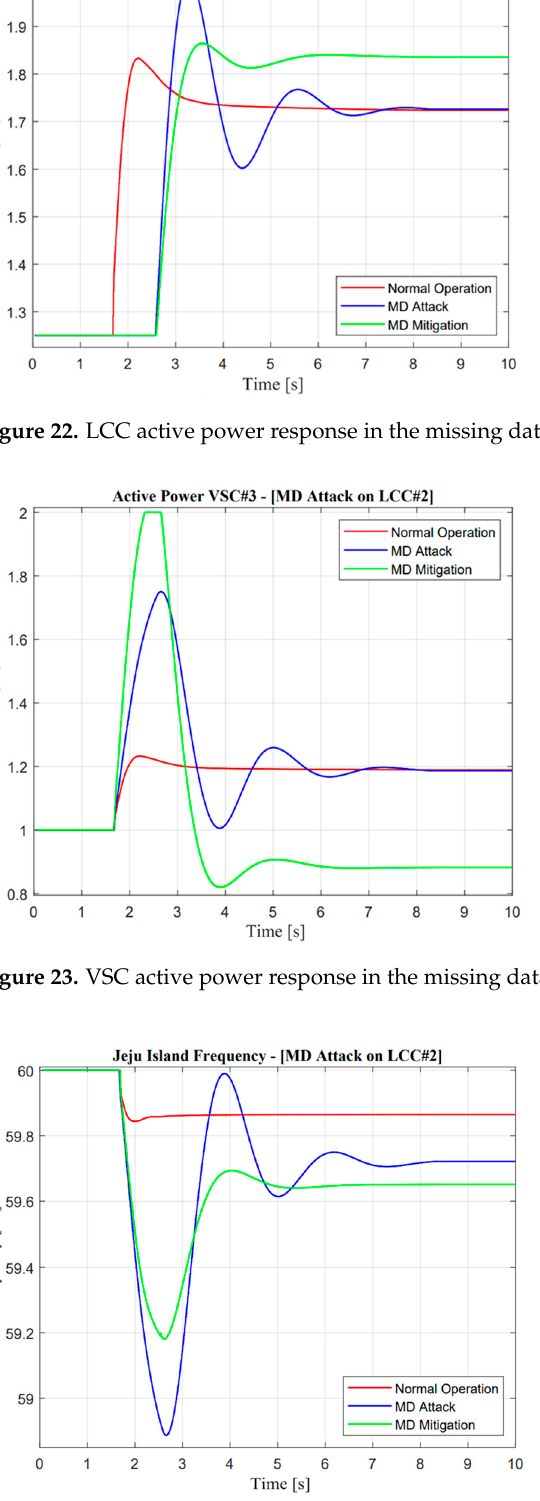
Figure 24. Jeju Island frequency in the missing data attack operation.